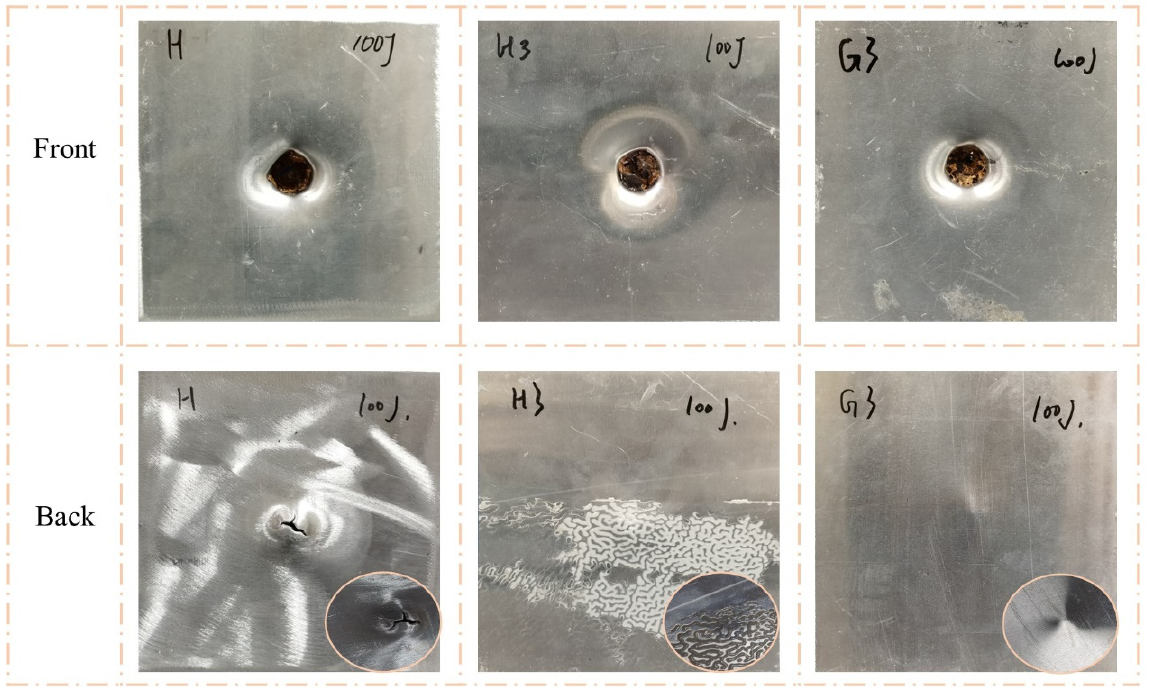
Figure 8. Damage modes of H, H3, and G3 under 100 J impact energy with hemisphere impactor.